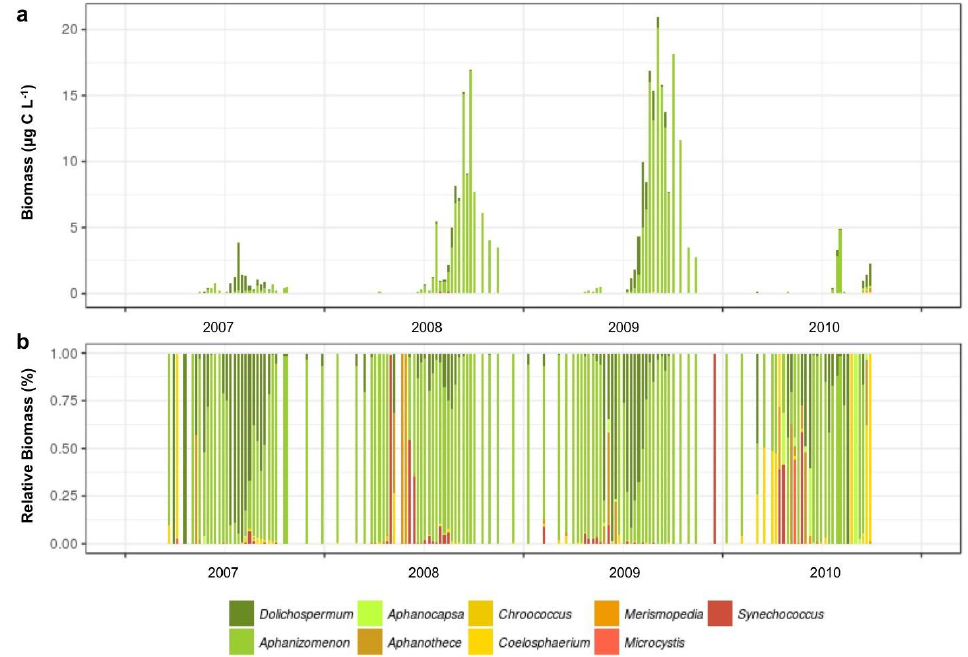
Figure 5. Taxonomic composition of cyanobacteria genera sampled from Vancouver Lake from January 2007 to December 2010. ( a ) Total carbon biomass of each cyanobacterial genus; ( b ) relative biomass of each cyanobacterial genus. Data from [62] and G. Rollwagen-Bollens et al.